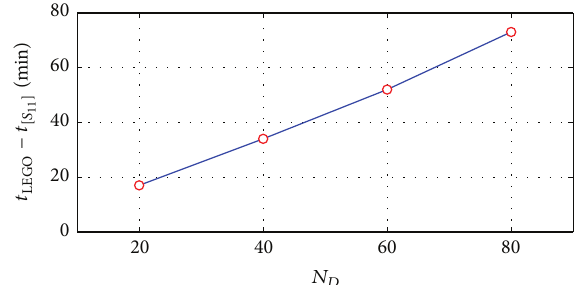
Figure 11: Microplasma rods: computational times minus the time taken to compute [𝑆 11 ] for the problems of Figures 8 and 9 at 𝑓 = 10